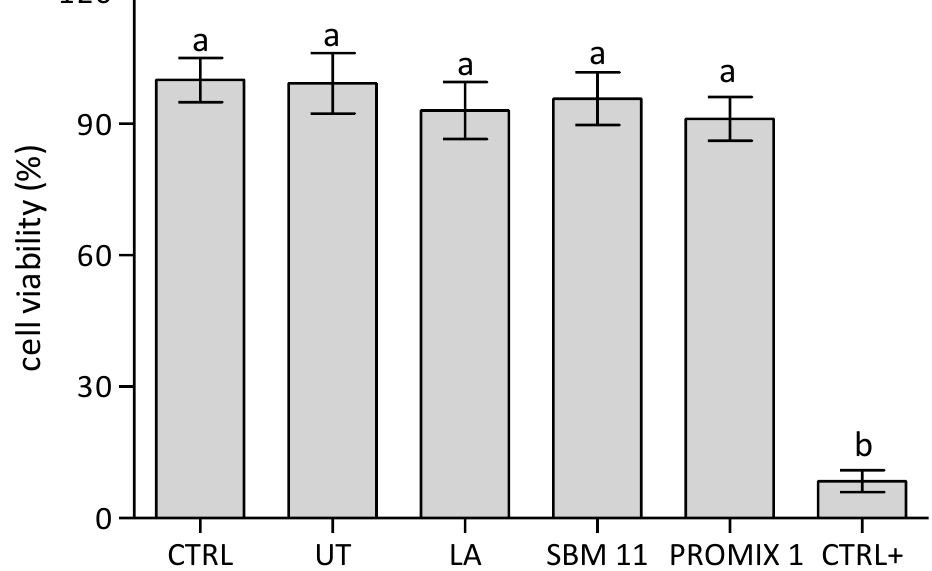
Figure 5. MTT cytotoxicity tests on Namalwa cells treated with 200 µ g of seaweed water extracts for 24 h. Results are compared to untreated cells (CTR) and cells lysed with 0.1% Triton X-100 (CTR+). Representative measurements of three distinct sets of data. Data were submitted to one-way analysis of variance (ANOVA), different letters: Tukey’s post hoc method was applied to establish significant differences among samples ( p < 0.05).